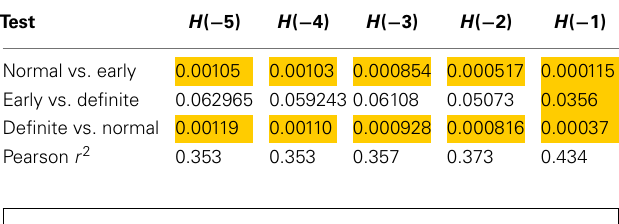
Table 3 | Results of Mann–Whitney tests for Renyi entropy calculated with negative exponents and using method 6 .